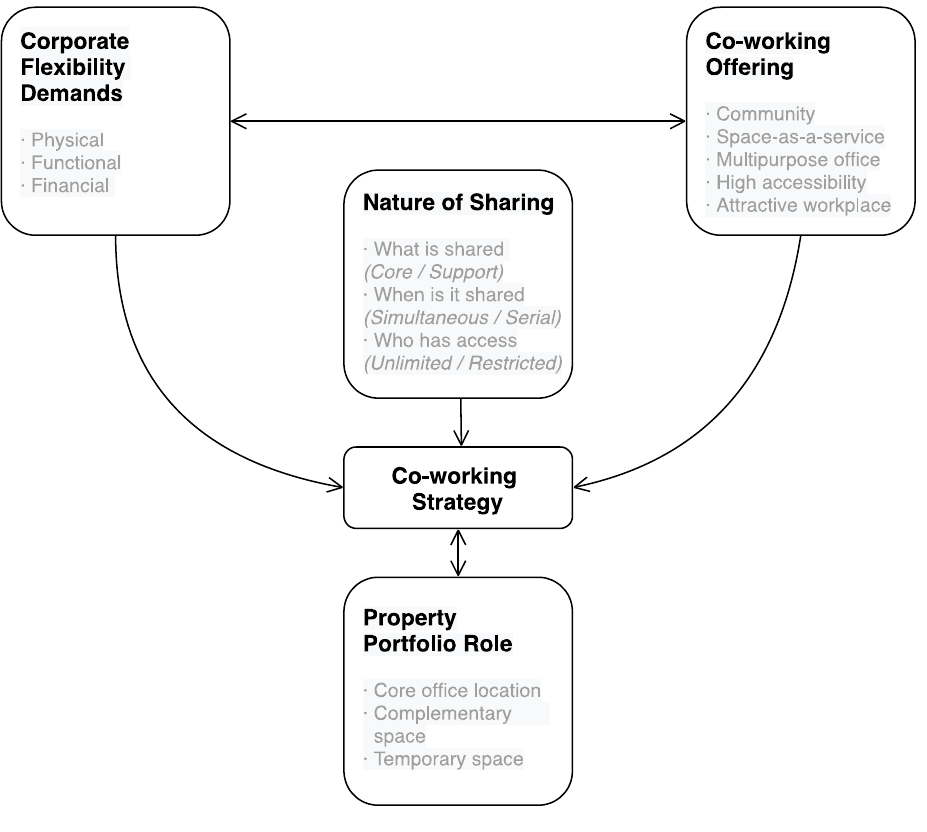
Figure 1. Summary of findings from literature.